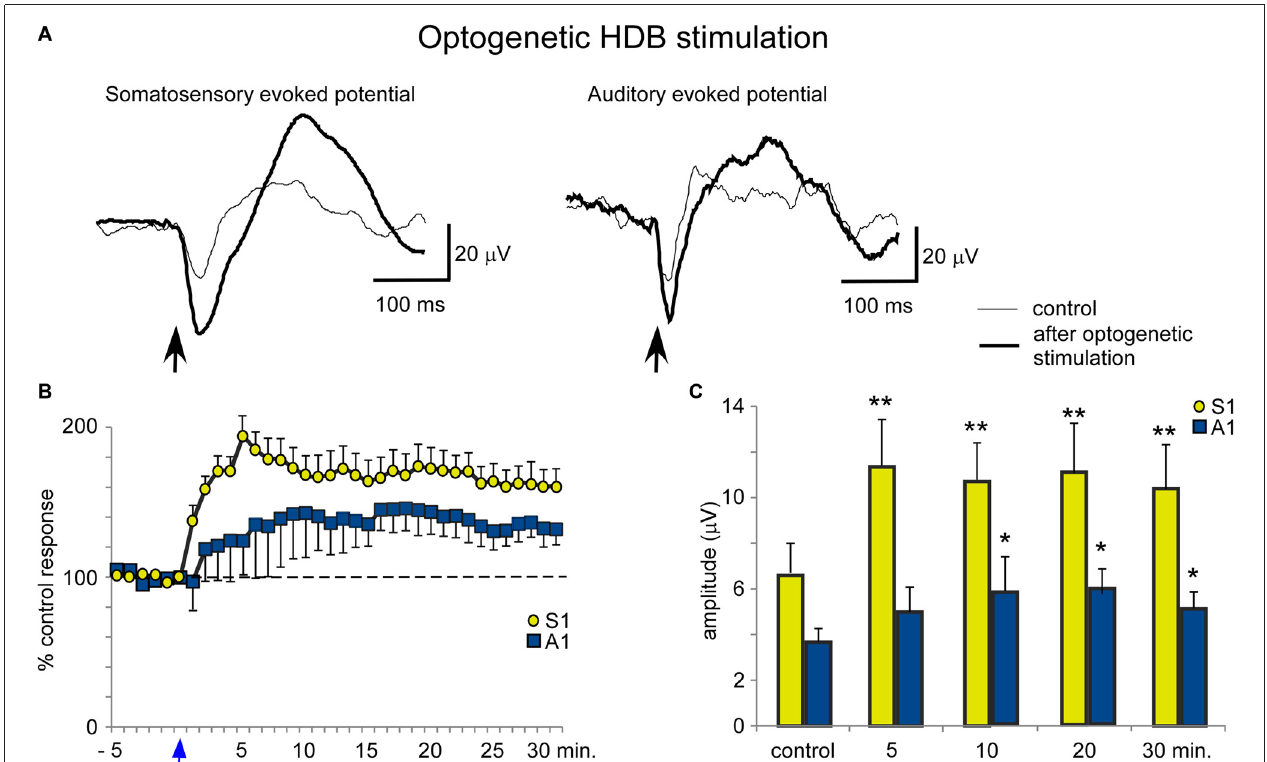
FIGURE 7 | Blue light stimulation of HDB nucleus induces an increase of somatosensory and auditory evoked potentials. (A) Raw data shows an important increase of the somatosensory evoked potentials and a modest increase of the auditory evoked potentials (control and 5 min after blue light stimulation; thin and thick traces, respectively). (B) Plot shows the time course of evoked potential amplitude in 12 cases. The 100% represent the mean amplitude during the control period. Note the greater increase in somatosensory evoked potentials (S1) than in auditory evoked potentials (A1) by HDB stimulation (reference 0 s; vertical blue arrow). (C) Plot of the mean amplitude measured in control and at 5, 10, 20 or 30 min after blue light stimulation at HDB area. The amplitude increase was larger for somatosensory than auditory evoked